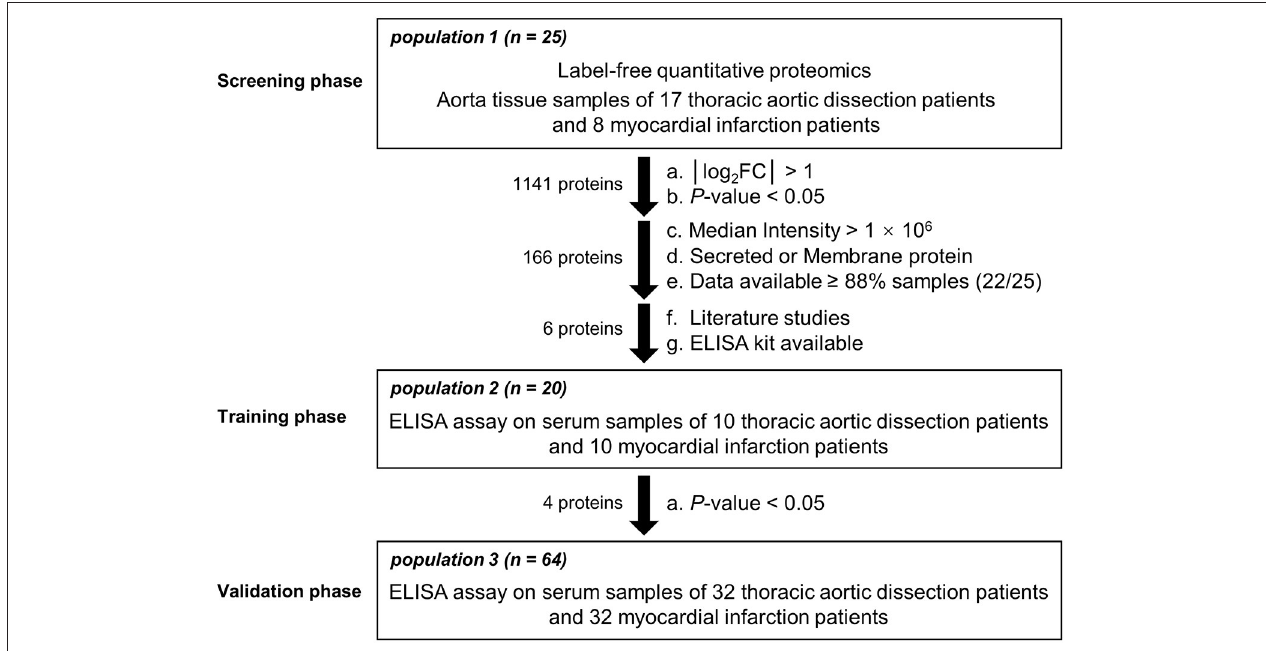
FIGURE 1 | Flowchart of the study design. Participants from 3 different populations were entered into the screening, training, and validation